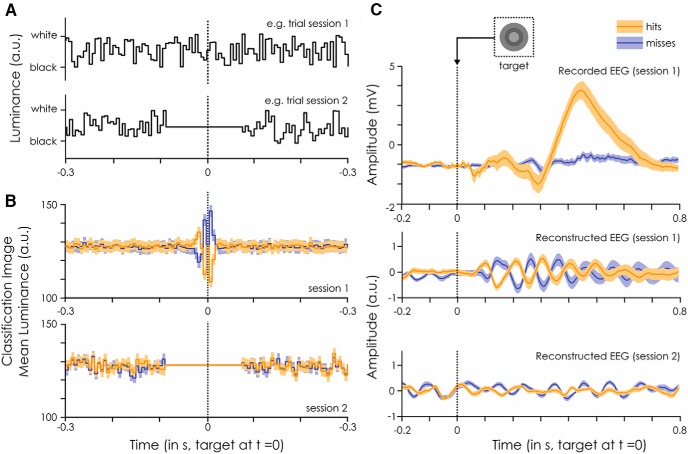
Classification image and evoked response. A, Example stimuli sequences for session 1, when the EEG was recorded, and session 2, when only the behavioral response was recorded. The sequences are centered on the embedded target presentation (at t = 0 ms). B, Classification image of the luminance values around the target (at t = 0 ms) for detected (orange) and missed (blue) targets. Darker colors represent the mean across subjects and trials. The lighter shades represent the standard error of the mean across subjects. The dotted line represents target presentation. Note that the same sequences were shown to all subjects in session 2. C, ERP evoked by the detected (orange) and missed (blue) targets embedded within the WN sequences. These are computed separately for the recorded EEG for session 1 (top) and the reconstructed EEG for session 1 (middle) and 2 (bottom). Note the absence of visible target-evoked ERP in reconstructed signals for session 2 (bottom). While there seems to be a very strong phase opposition between hits and misses in the reconstructed EEG to session 1, this is likely to be an artifact of the strong relationship between luminance value and behavioral outcome illustrated in B, rather than a direct relationship between phase and perception. Darker colors represent the mean across trials and the lighter shades represent the standard error of the mean across subjects. The dotted line represents target presentation.